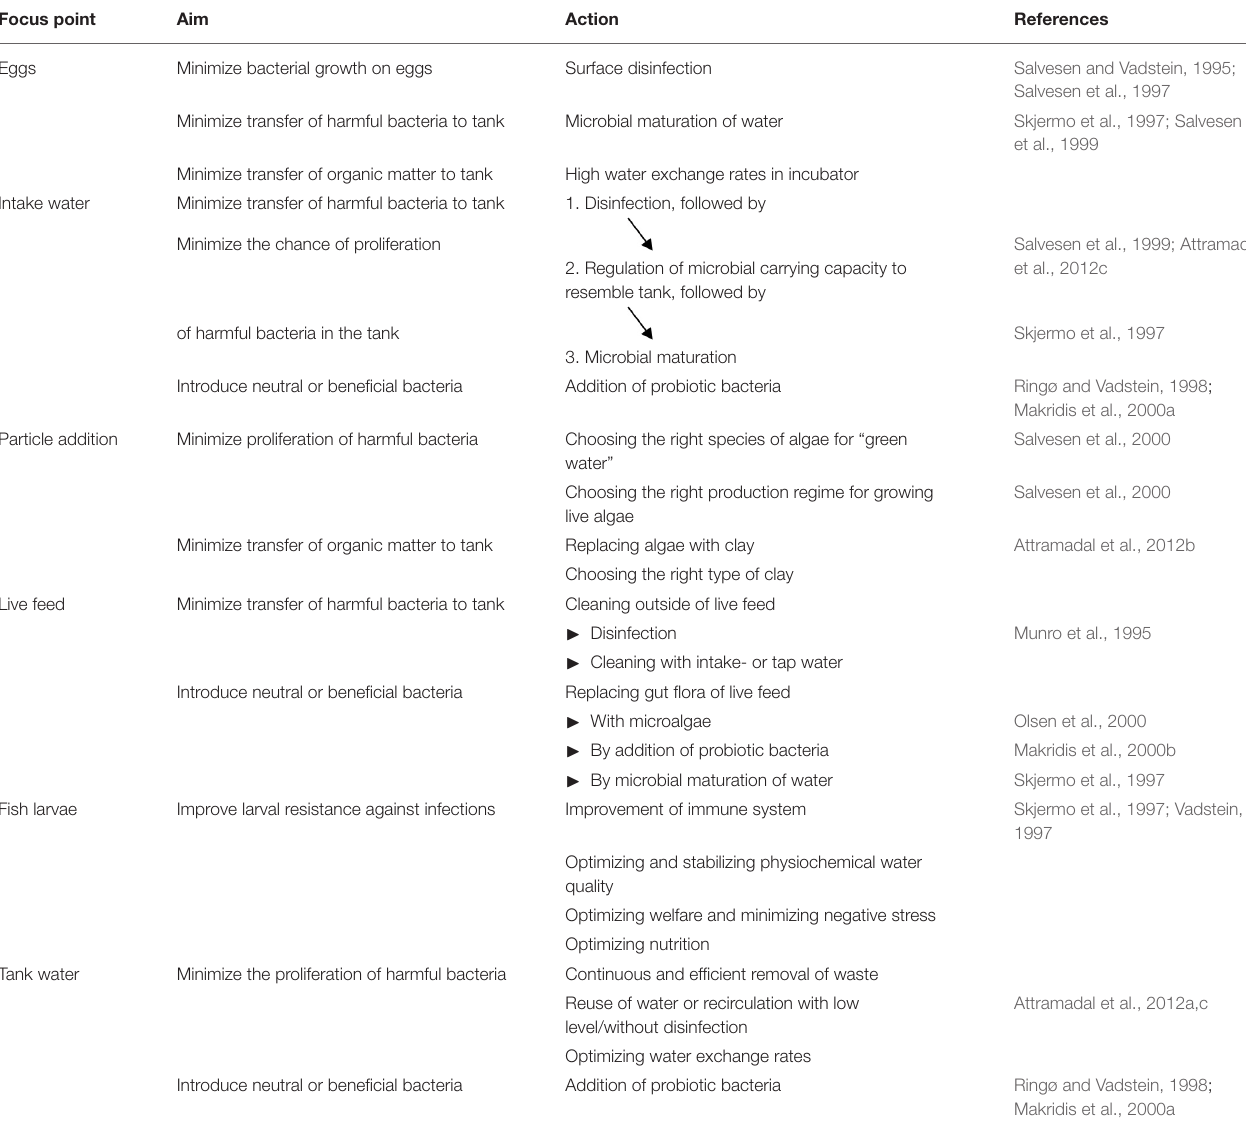
TABLE 4 | Approaches to manage the microbial communities of each component part of the marine hatchery. Focus